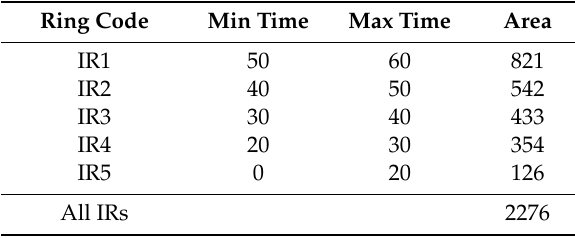
Figure 2. Spatial extent and distribution of the transportation time belts (isochronous rings) from pick-up points to the cogeneration facility in the study area. Table 1. Minimum and maximum transportation times (in minutes) from the pick-up point to plant facility, and surface area (in km 2 ) of each isochronous ring (IR).